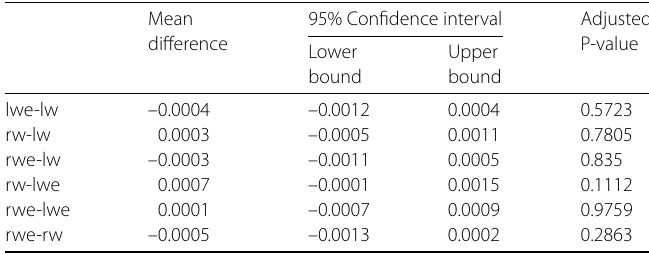
Table 6 ANOVA results to test for correlation of political orientation and extremity with text-based indicators of certainty Degree of Sum of square Mean square F value Pr (> F ) freedom Political orientation 1 0.00000004 0.00000004 1.08 0.299 Political extremity 1 0.00000019 0.00000019 5.44 0.020 Residuals 19,997 0.00060811 0.00000003 – –